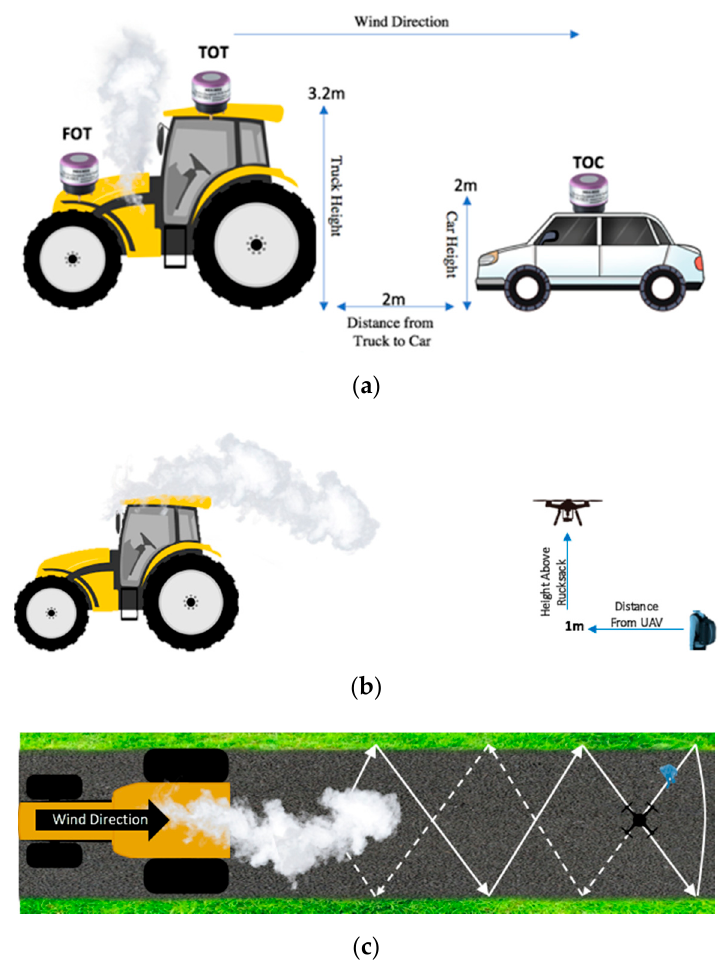
Figure 4. ( a ) The experimental setup for Stage A, where three ground truth locations (purple sensor) are placed on the front of the truck next to the exhaust, on top of the truck behind the exhaust, and two meters away from the truck at a height of two meters on top of a second vehicle; ( b ) Side view of the experimental setup for Stage B. One sensor was attached to the UAV as it flew along a predetermined zig-zag flight path with and against the wind direction. The other sensor was attached to a rucksack and walked approximately one meter below and one meter behind the UAV as it followed the flight path, which was used as a ground truth to validate the calibration of the sensor that was attached to the UAV. This representation is not to scale; ( c ) Top view of the experimental setup for Stage B.